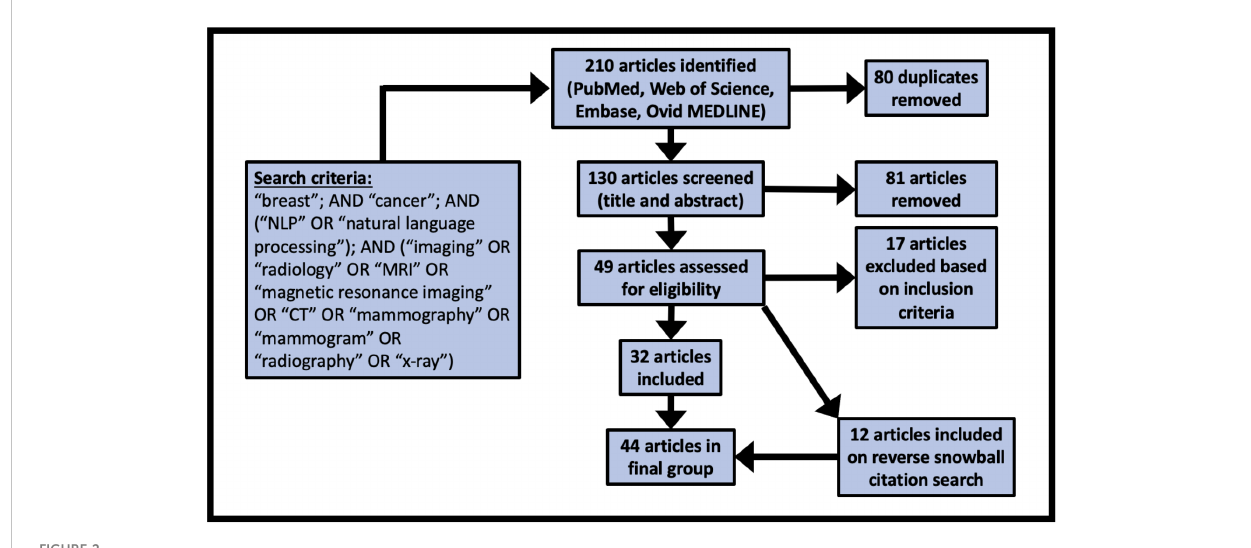
FIGURE 2 PRISMA diagram demonstrating the search and identi fi cation process for the scoping